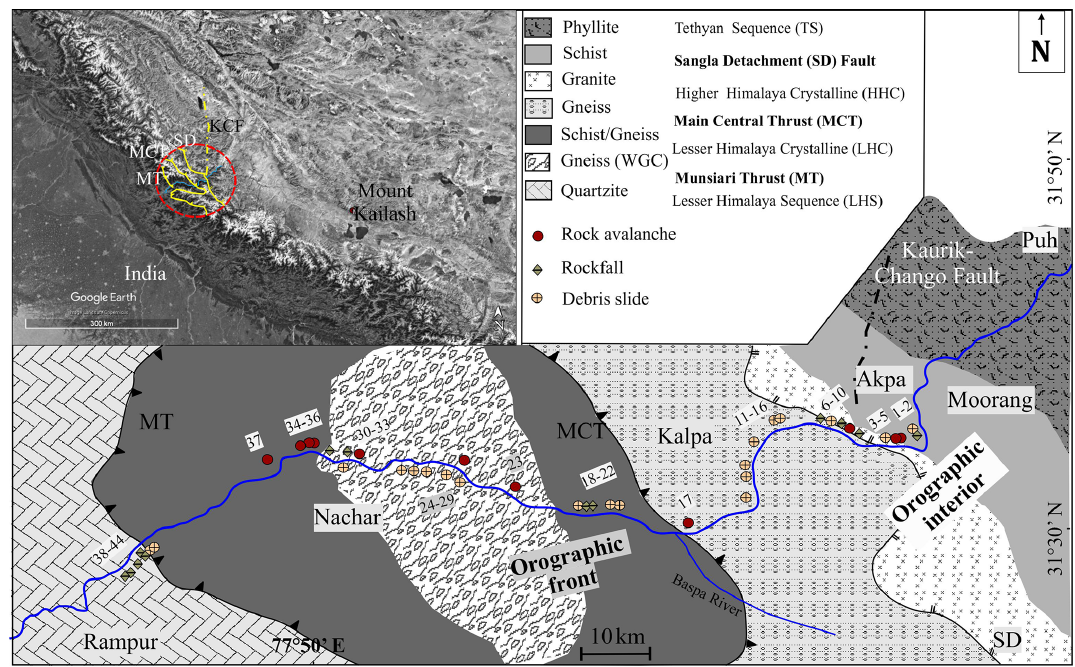
Figure 1. Geological setting. WGC stands for Wangtu Gneissic Complex. The dashed red circle in the inset (© Google Earth) represents the region within a 100km radius from the Satluj River (marked as a blue line) that was used to determine the earthquake distribution in the area. Yellow lines represent the regional faults in the region. KCF in the inset refers to the Kaurik–Chango fault. The numbers 1–44 refer to serial number of landslides in Table 1.